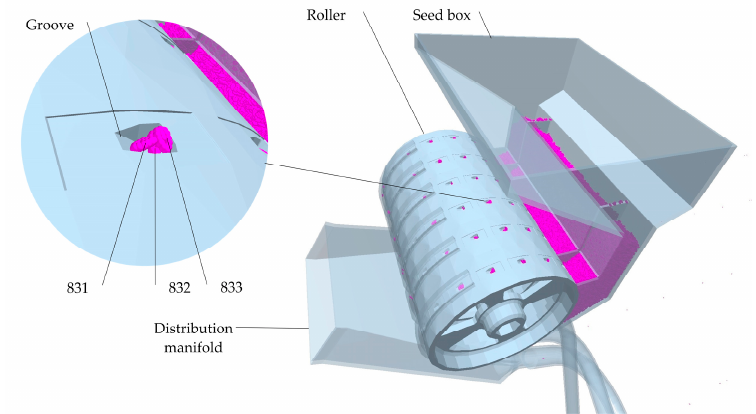
Figure 11. Example of the force and speed analysis curve names of sesame.